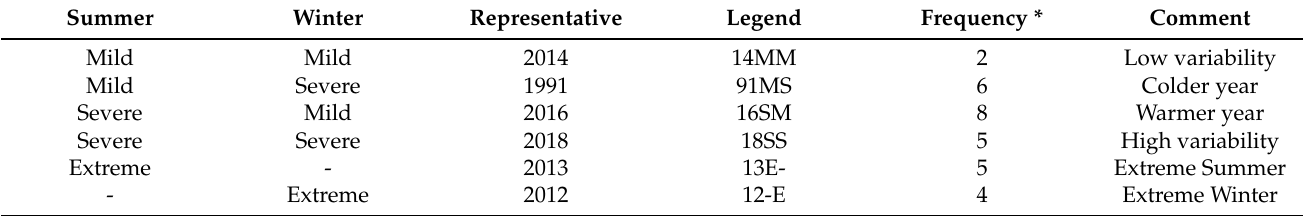
Table 4. Representative years of different weather scenarios in